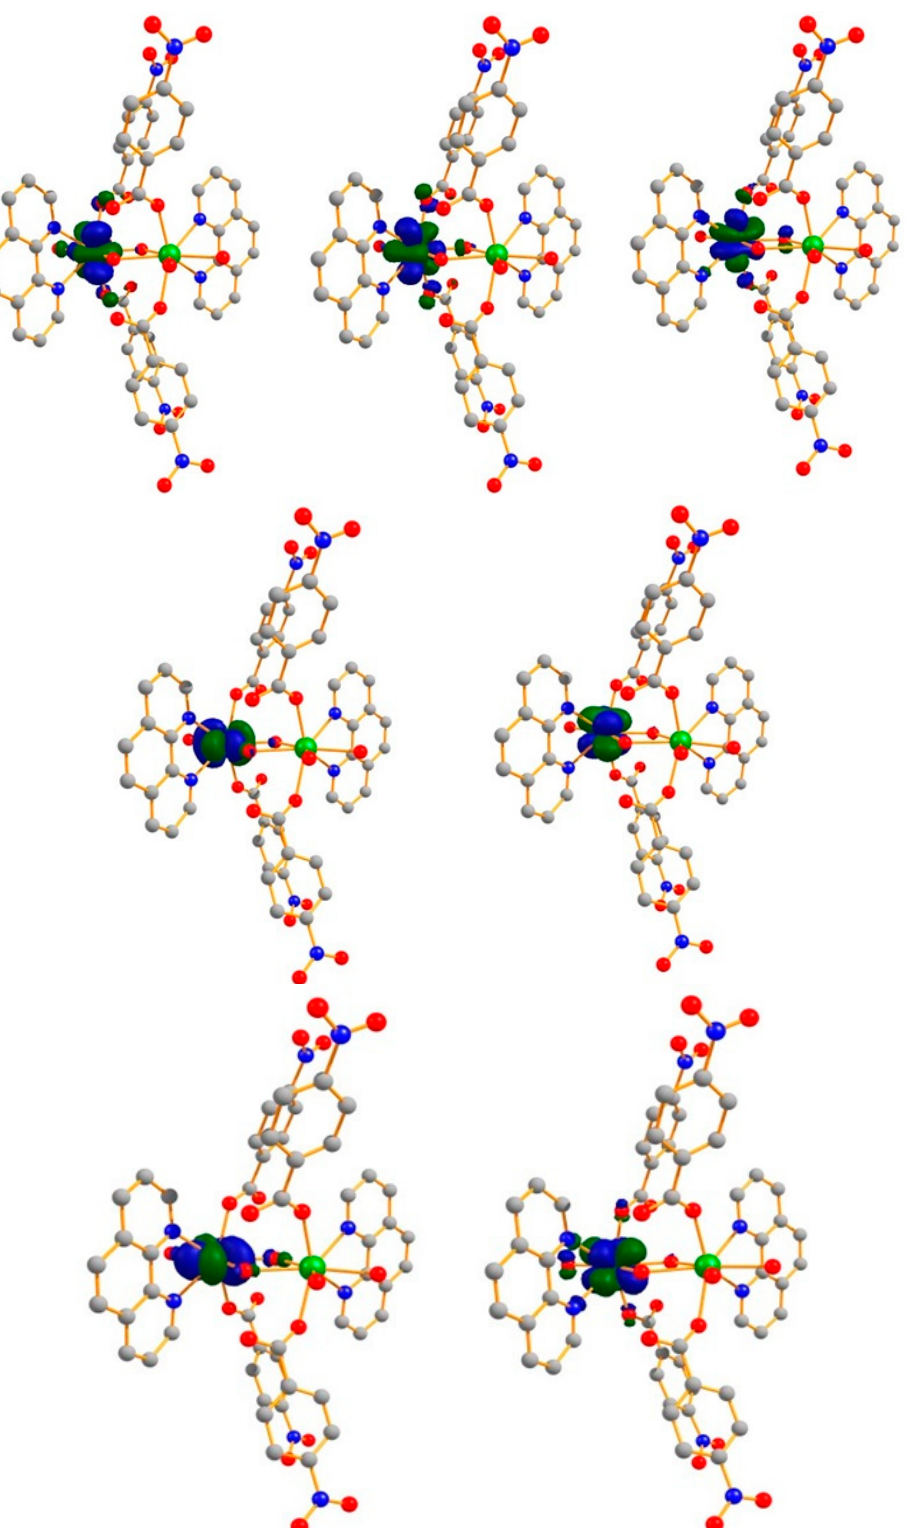
Figure 7. Magnetic orbitals on one of the Gd centre in complex 1.